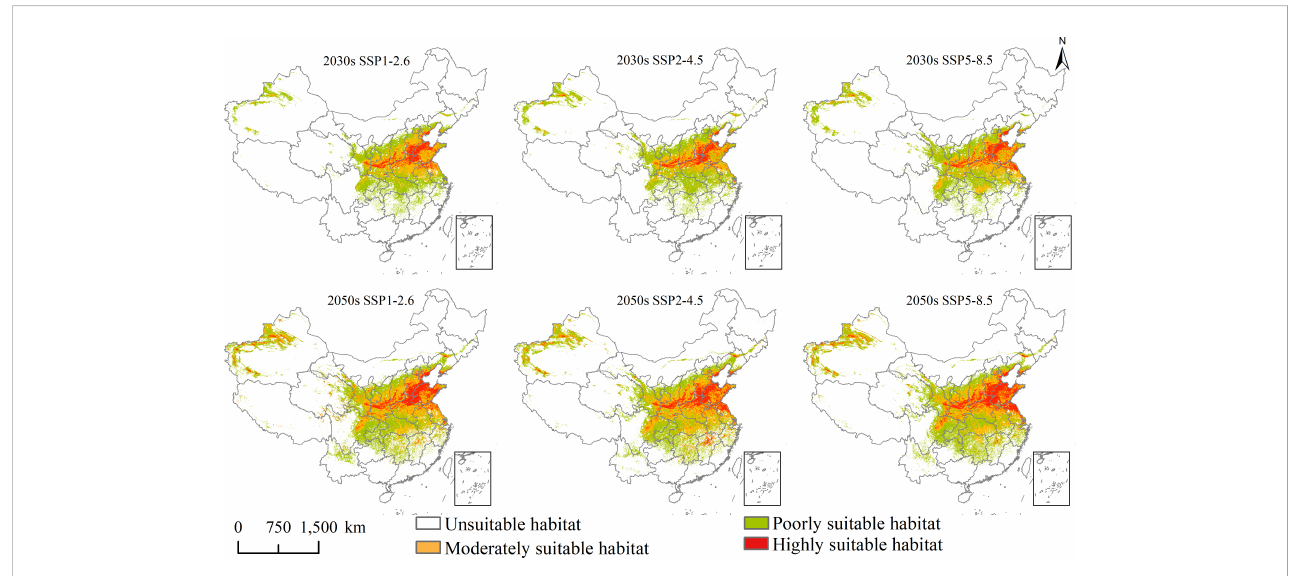
FIGURE 5 Future potential geographical distribution of Aegilops tauschii under three scenarios in the 2030s and 2050s.